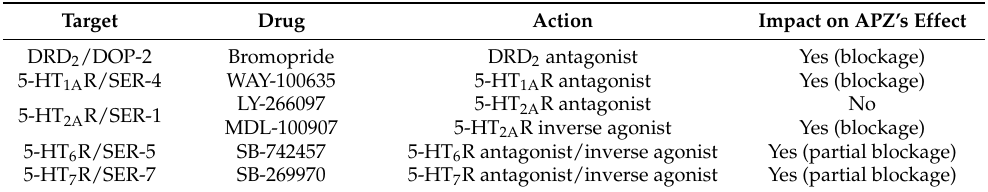
Table 1. Summary of the results of co-treatment of AT3q130 animals with aripiprazole and selective antagonists of dopamine and serotonin